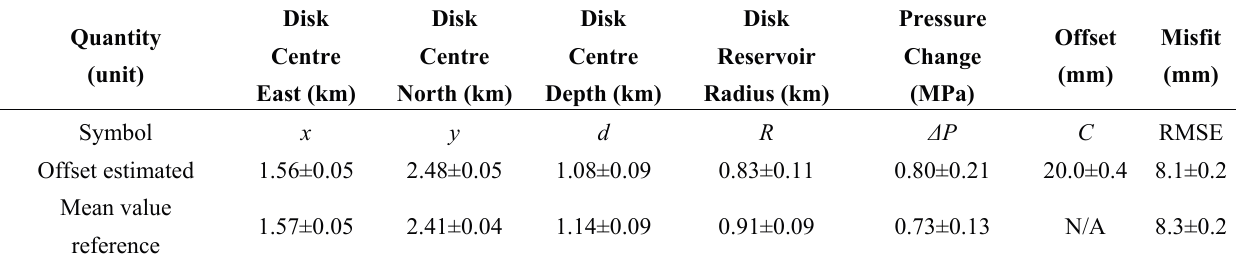
Table 2. Best Fit Poroelastic disk reservoir model parameters and uncertainty. A: offset between InSAR and model estimated. B: mean value as InSAR reference.